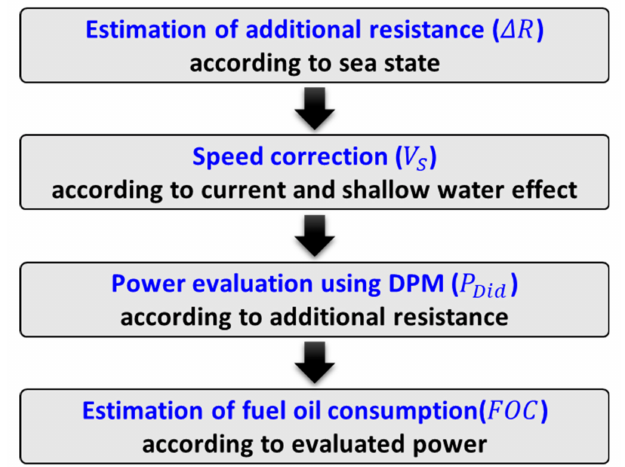
Figure 4. Process of the estimation of fuel oil consumption using ISO